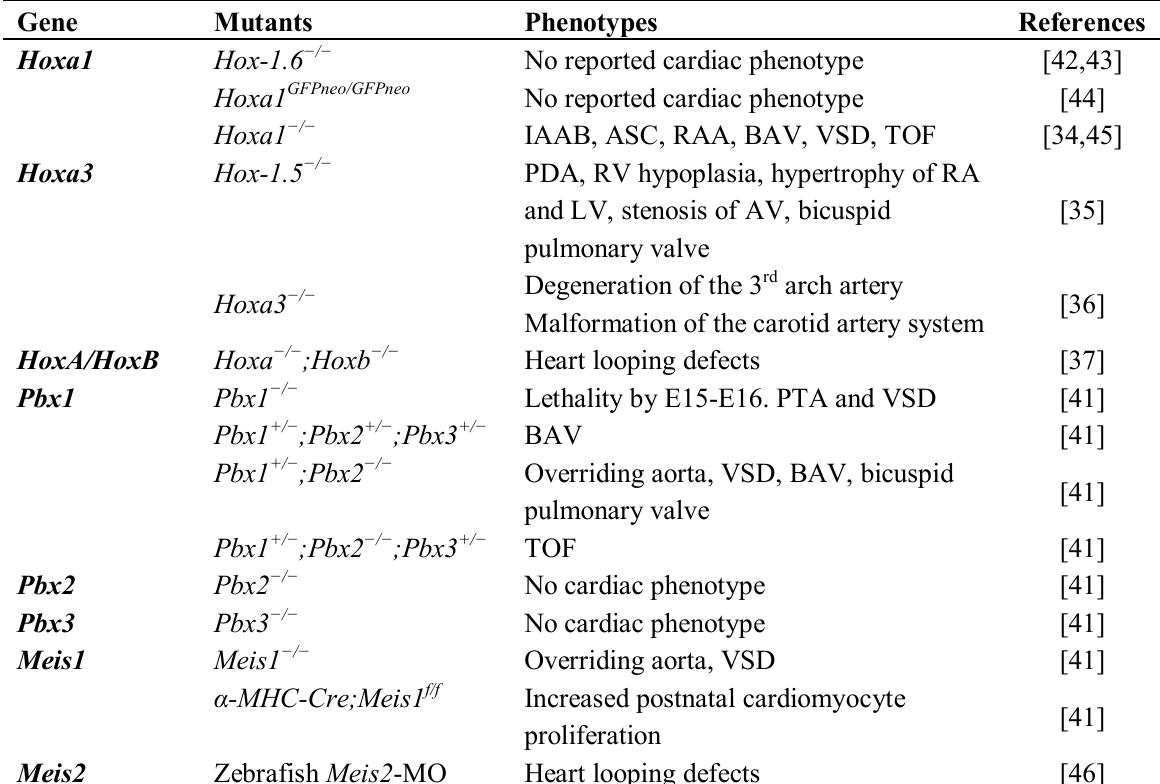
Table 1. Cardiac phenotypes associated with Hox , Pbx and Meis loss-of-function.